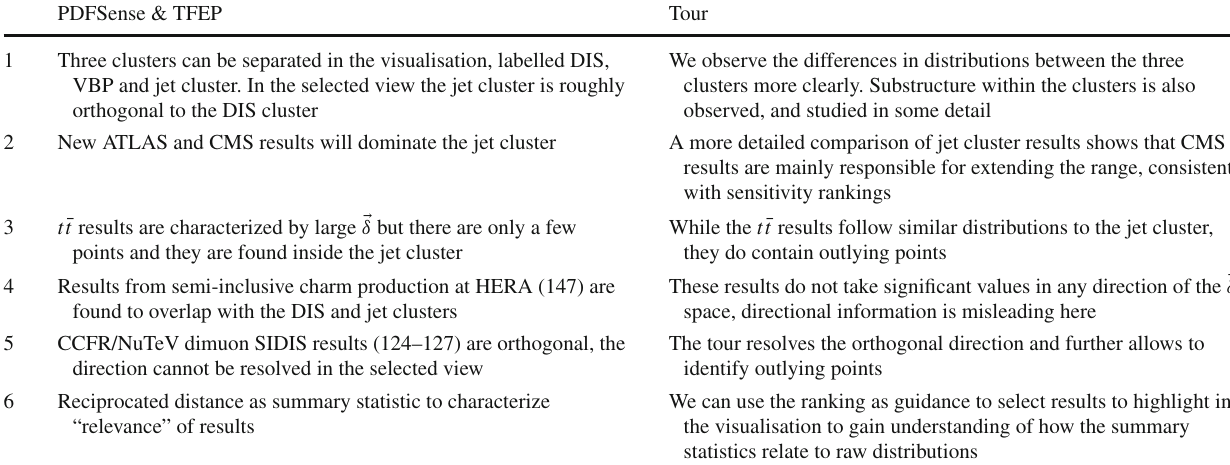
Table 1 Summary of key findings, comparing observations made with visualising PDFSense results with the TFEP and with additional insights that can be made using tour. A complete list of experimental datasets together with their CTEQ labelling IDs is given in Appendix